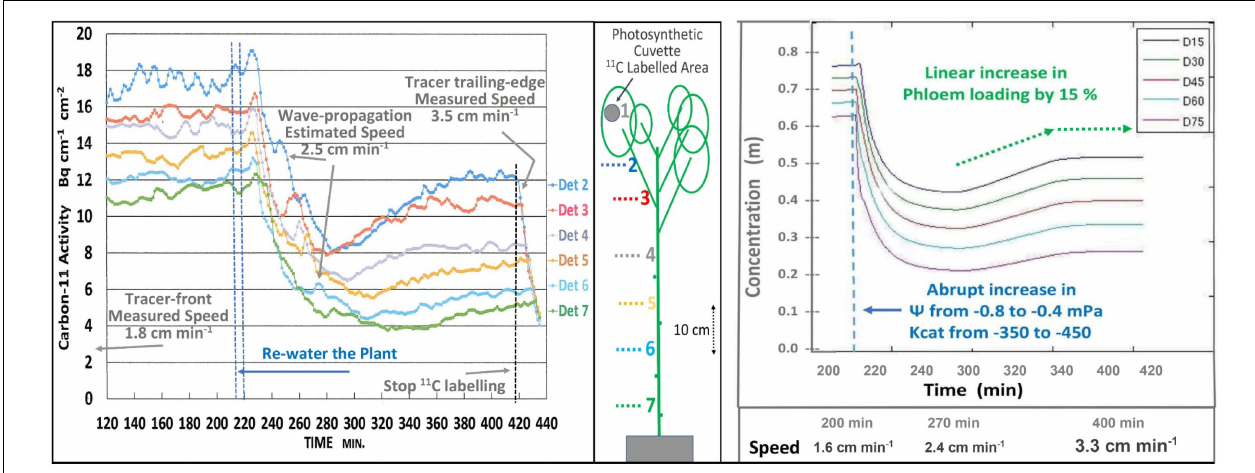
FIGURE 3 | Left ; Minute-by-minute 11 C activities at numbered detector positions along a moderately drought-stressed Cotton plant during the steady state (final 300 min) of a 420 min Extended Square Wave input of 11 CO 2 , before, during, and after re-watering of the plant. Right ; Output of a time-dependent version of the Münch-Horwitz model of a phloem sieve tube subjected to the same set of input conditions and changes believed to have occurred in the experimental plant.